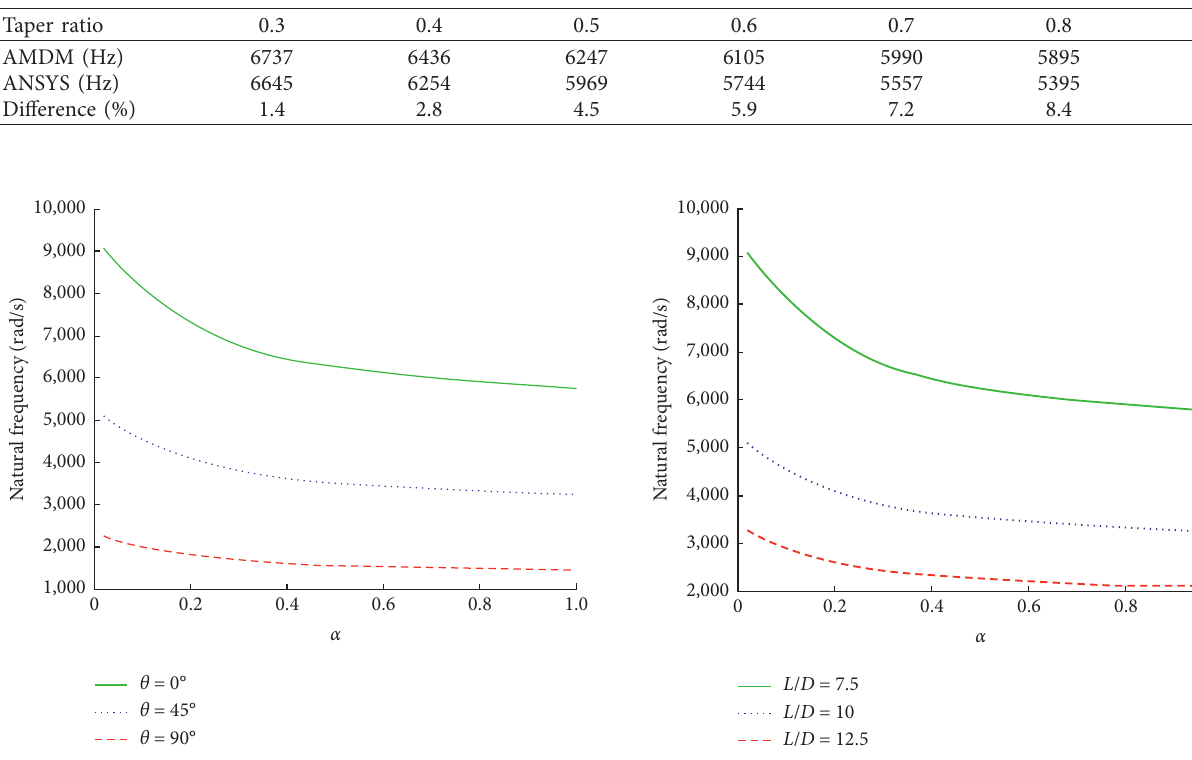
Figure 2: Finite element model of the tapered composite boring bar. Table 2: Comparison of natural frequencies obtained by the AMDM and the